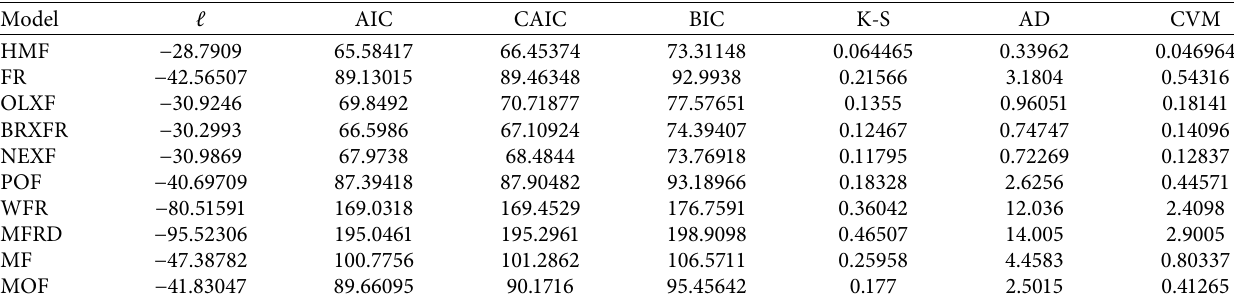
Table 8: Log-likelihood and comparison criteria for annual maximum temperature